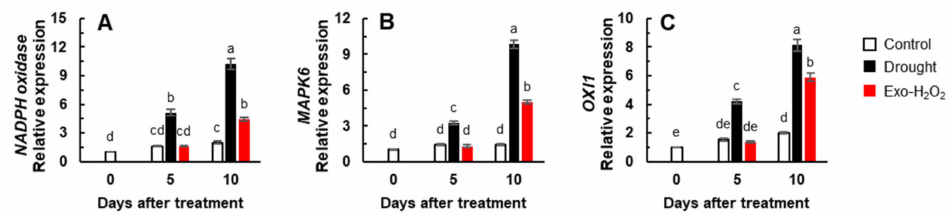
Figure 3. Changes in the expression of ( A ) NADPH oxidase , ( B ) transcription factor MAPK6 , and ( C ) oxidative signal-inducible ( OXI1 ) gene in the leaves of control, drought-, or exogenous H 2 O 2 (Exo- H 2 O 2 )-treated plants for 10 days. Results are represented as mean ± SE for n = 3. Different letters indicate values that are significantly different at p < 0.05 according to Duncan’s multiple range